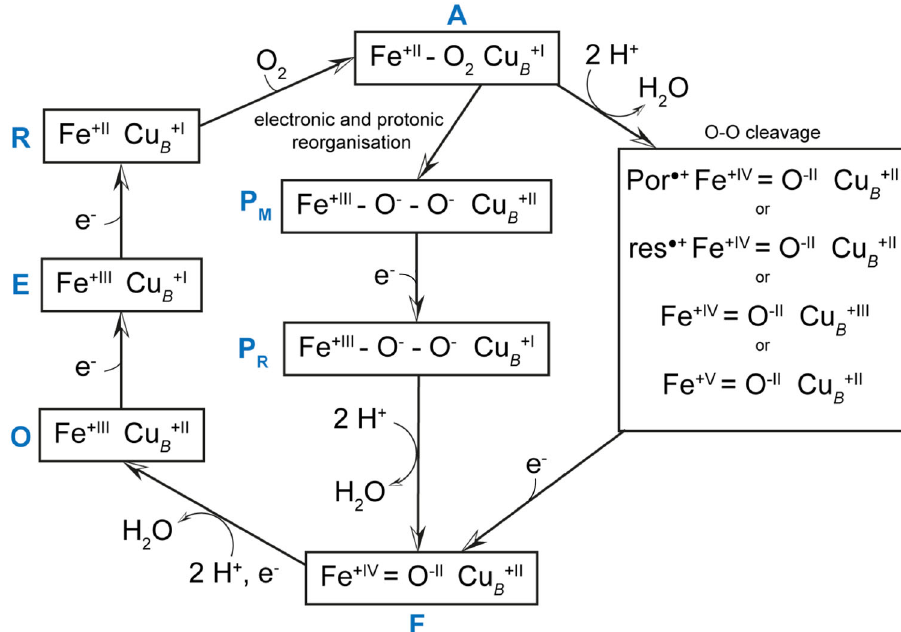
Fig. 1 The structure of oxygen intermediates in the catalytic cycle of cytochrome c oxidase. As the chemical composition of the P -state remains unsettled, alternative proposed structures are presented (intact dioxygen bond left, split bond right). Por (cid:129) and res (cid:129) denote radicals of the porphyrin ring and a spatially close amino acid residue,